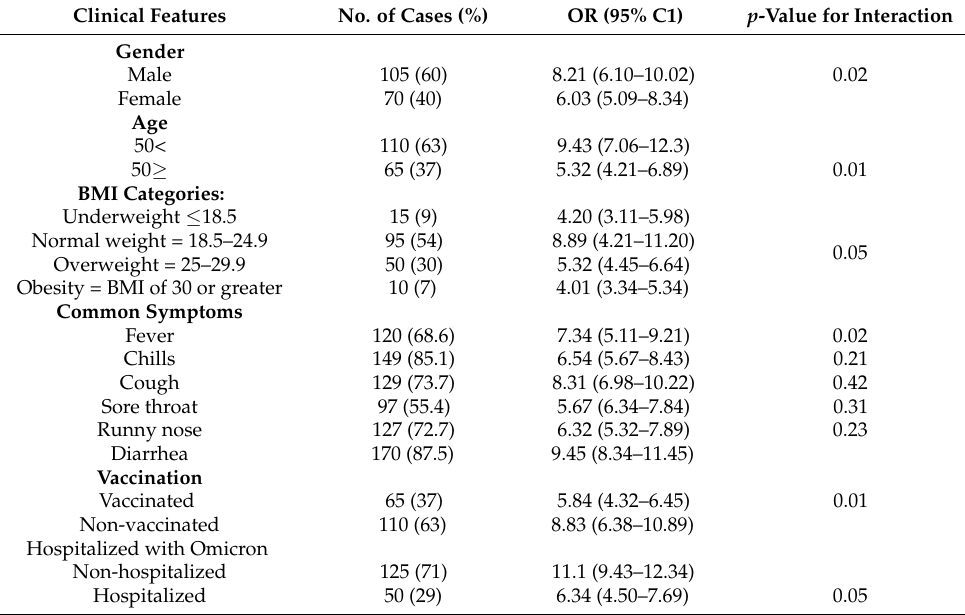
Table 1. Clinical features of patients with the Omicron